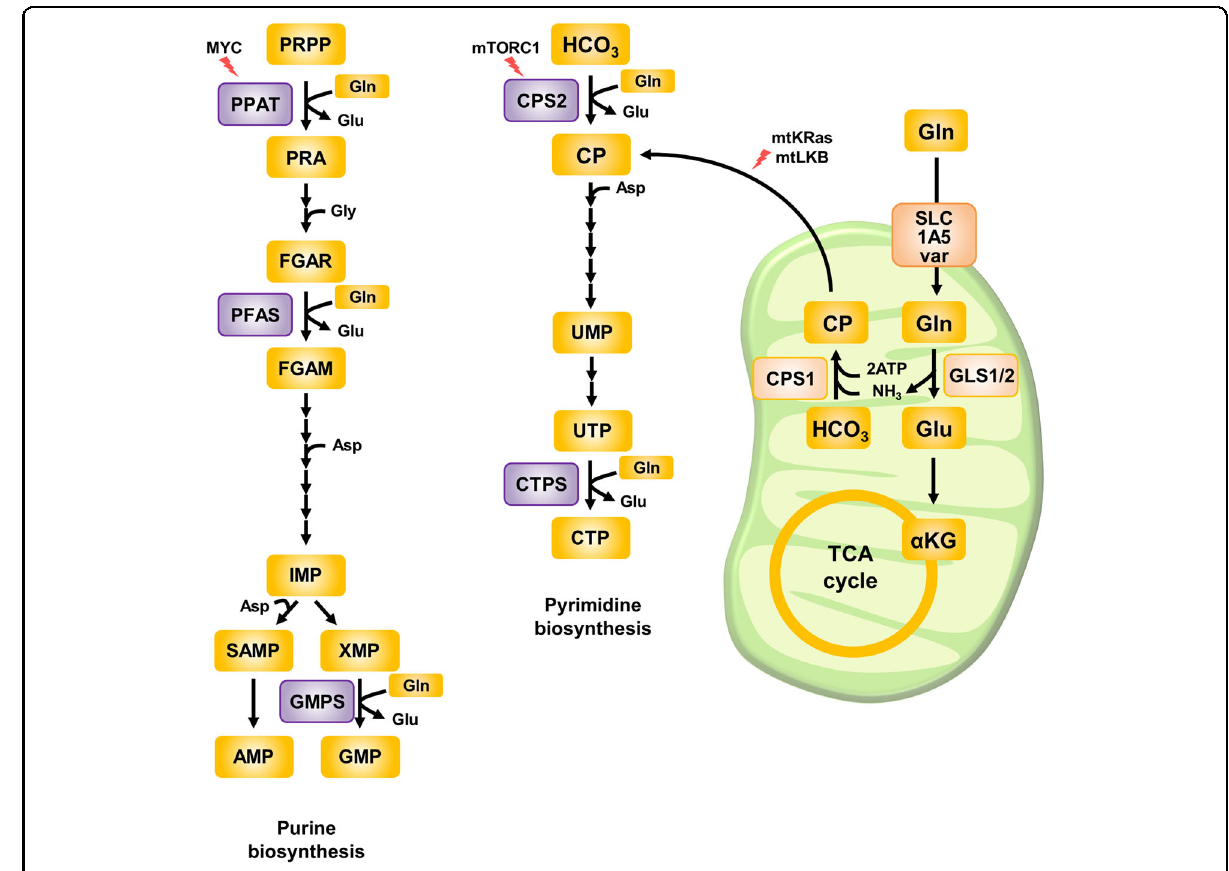
Fig. 2 Nucleotide biosynthesis from glutamine. In purine biosynthesis, two glutamine molecules are consumed to synthesize AMP, and three glutamine molecules are used to synthesize GMP. Similarly, in pyrimidine biosynthesis, one glutamine molecule is consumed to synthesize UMP, and two glutamine molecules are spent to convert UTP into CTP. The initial step in de novo pyrimidine synthesis is the condensation reaction between glutamine and bicarbonate catalyzed by CPS to produce CP. In cells with an oncogenic mutational status, including K-Ras mutation, glutaminolysis sustains mitochondrial generation of CP by providing enough nitrogen fuel as ammonium ions, and mitochondrial CP then participates in cytosolic de novo pyrimidine synthesis. Glutamine-induced nucleotide biosynthesis is also enhanced by MYC or growth signals such as mTORC1 activation. PPAT phosphoribosyl pyrophosphate amidotransferase, PFAS phosphoribosylformylglycinamidine synthase, GMPS GMP synthetase, CPS carbamoyl phosphate synthetase, CTPS CTP synthetase, GLS glutaminase, PRPP 5-phosphoribosyl-1-pyrophosphate, PRA 5-phosphoribosyl-1-amine, FGAR N2- formyl-N1-(5-phospho- D -ribosyl)glycinamide, FGAM 2-(formamido)-N1-(5-phospho- D -ribosyl)acetamidine, IMP inosine monophosphate, SAMP adenylosuccinate, XMP xanthosine monophosphate, AMP adenosine monophosphate, GMP guanosine monophosphate, CP carbamoyl phosphate, UMP uridine monophosphate, UTP uridine triphosphate, CTP cytidine, Glu glutamine, Glu glutamate, α KG α